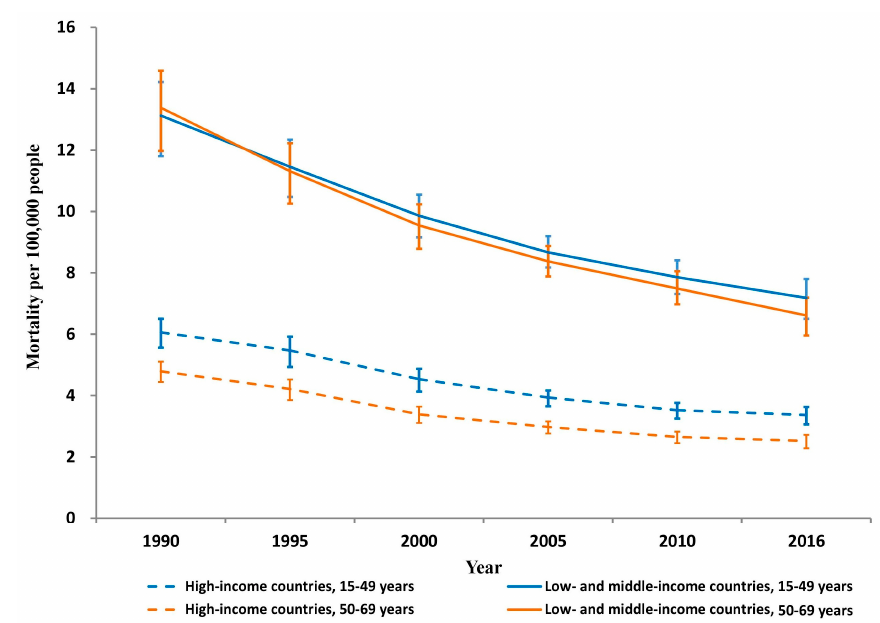
Figure 2 . Unintentional occupational injury mortality per 100,000 persons by country income and age group, 1990–2016.